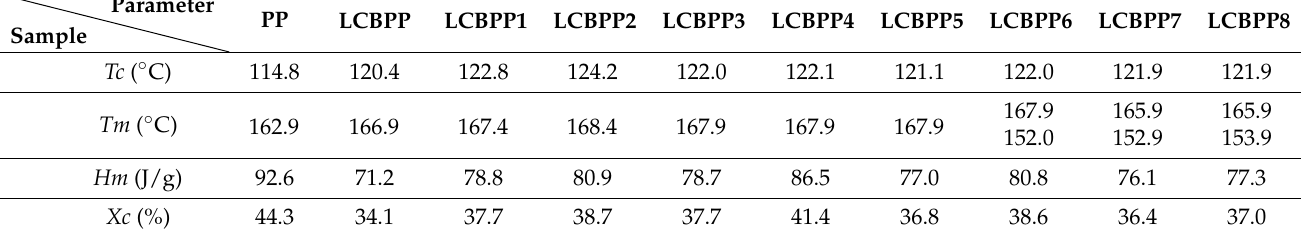
Table 3. Thermal parameters of test